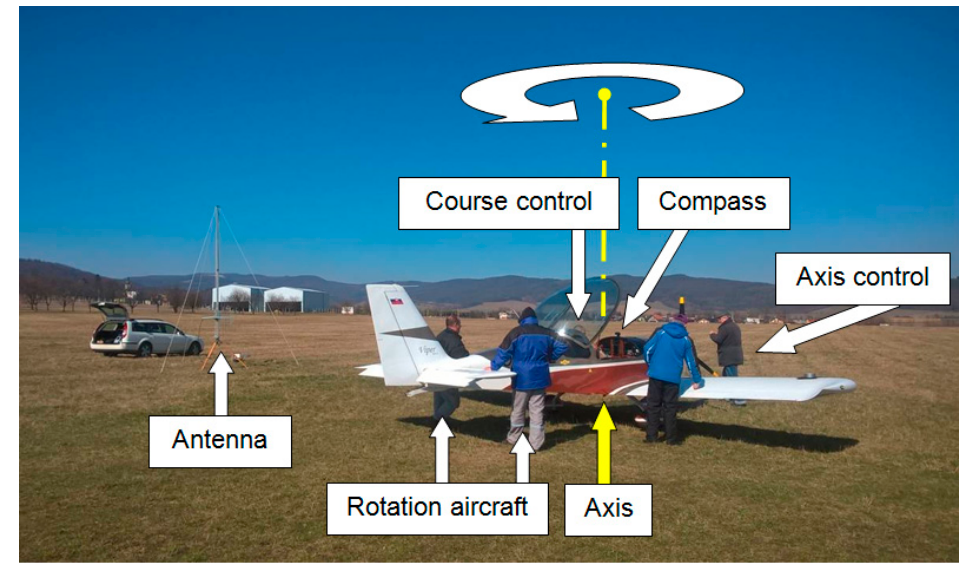
Figure 6. Activities of technical personnel in handling the aircraft during measurements.